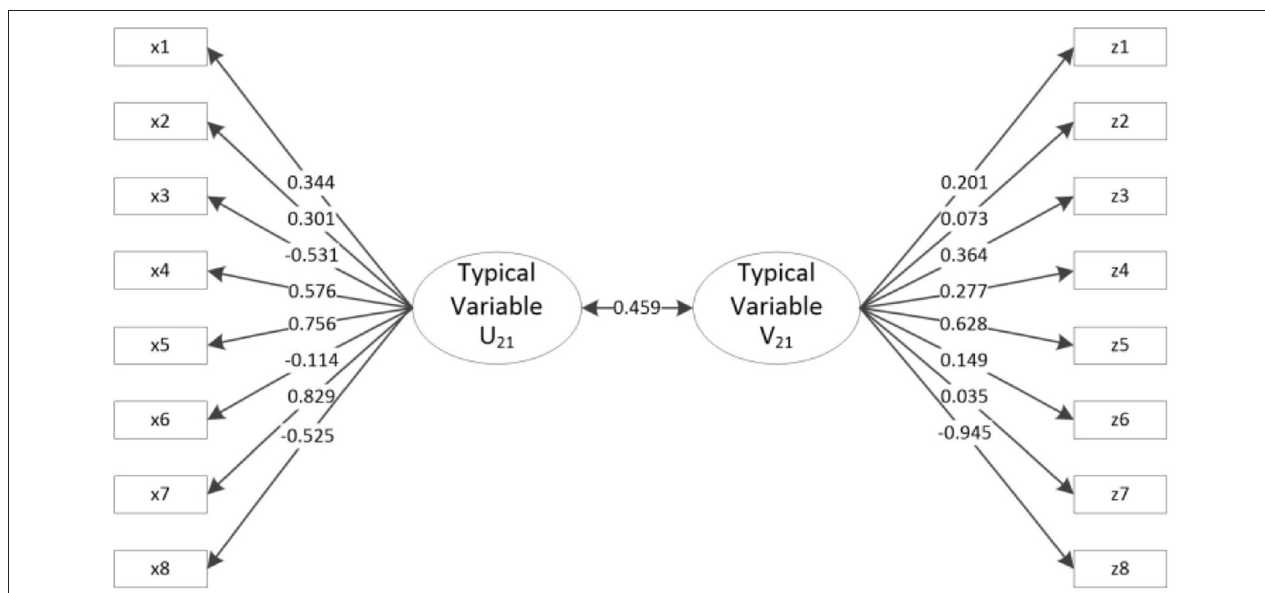
FIGURE 2 | Typical load coefficient and cross-load coefficient of motor performance and motor development.